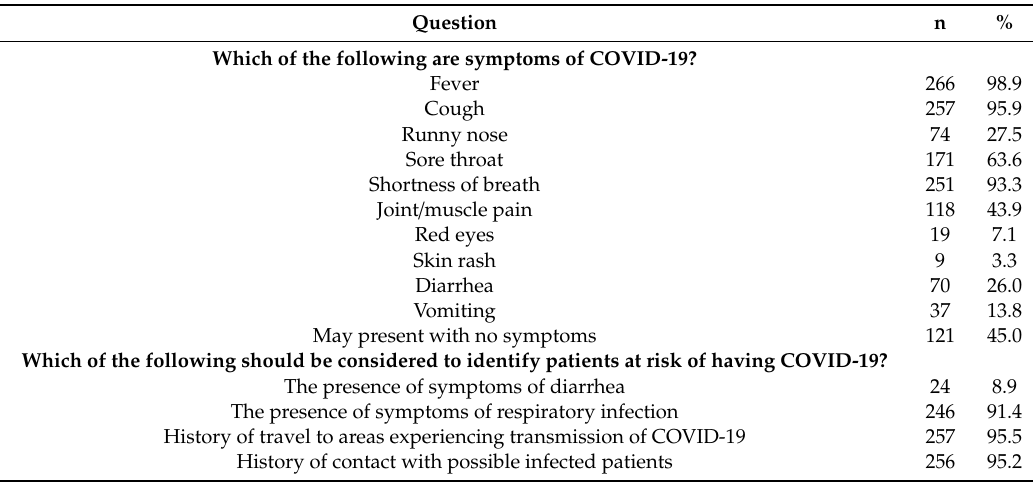
Table 2. Participants’ responses to knowledge questionnaire